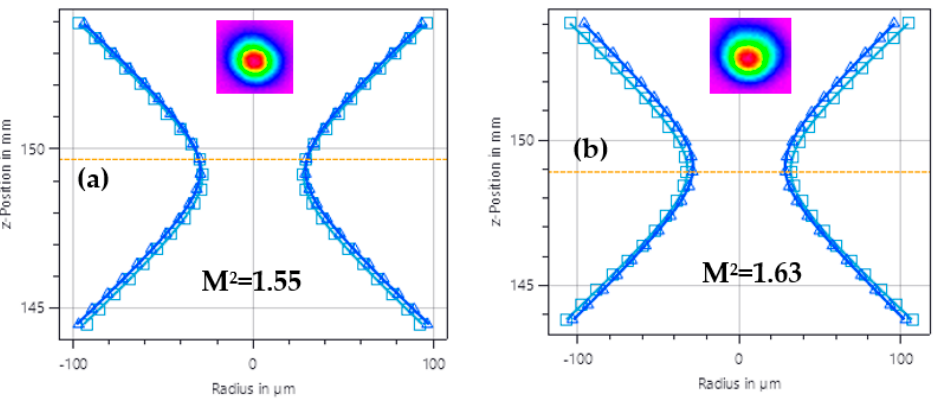
Figure 6. The M 2 value of the signal light before ( a ) and after ( b ) transmitting the home-made combiner.